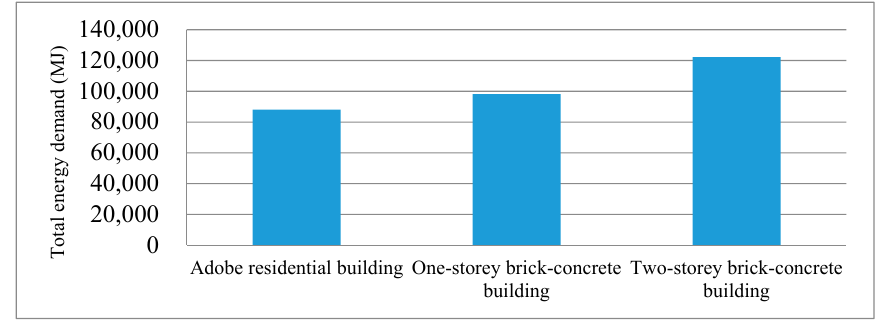
Figure 10. Total energy demand in the process of building use.